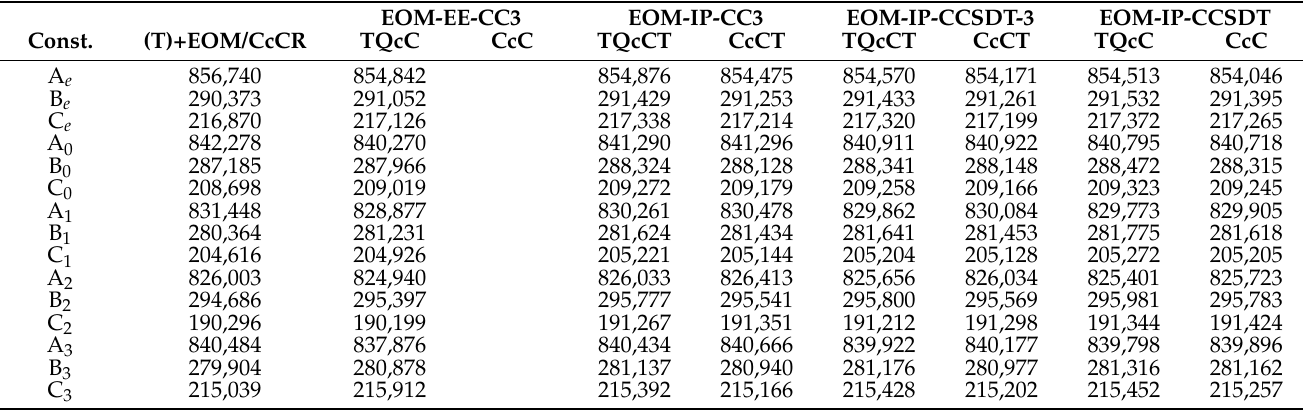
Table A3. ˜B 2 B 1 H 2 O + Rotational Constants (MHz).